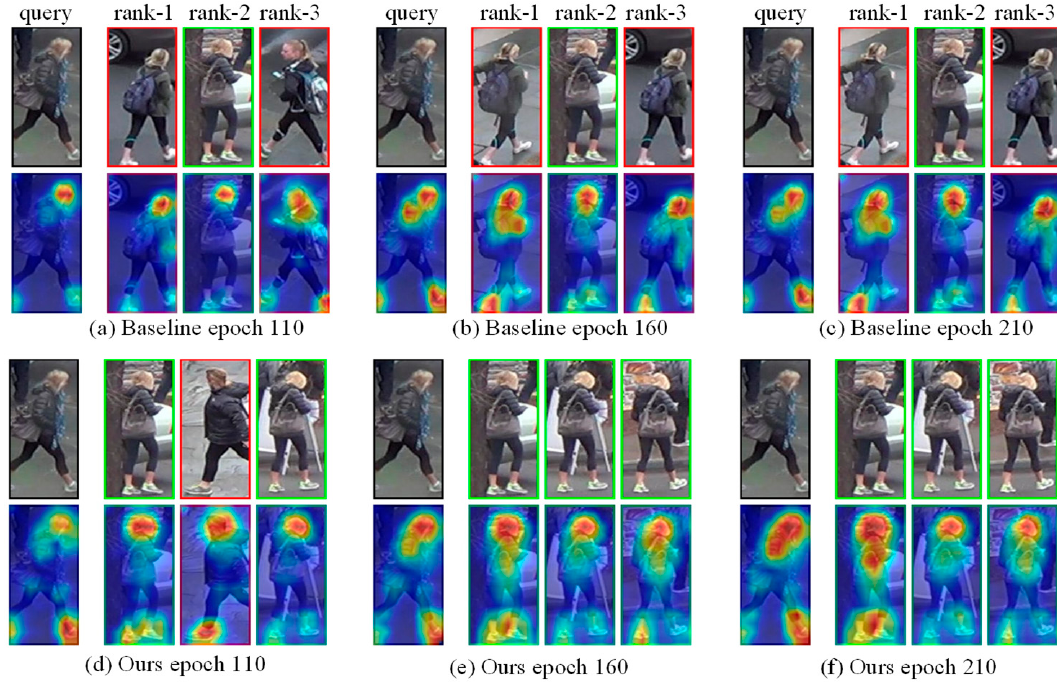
Figure 11. The ranking results and activation maps of baseline and self-erasing network at different epochs. Images with the green and red boxes are positive results and negative results.